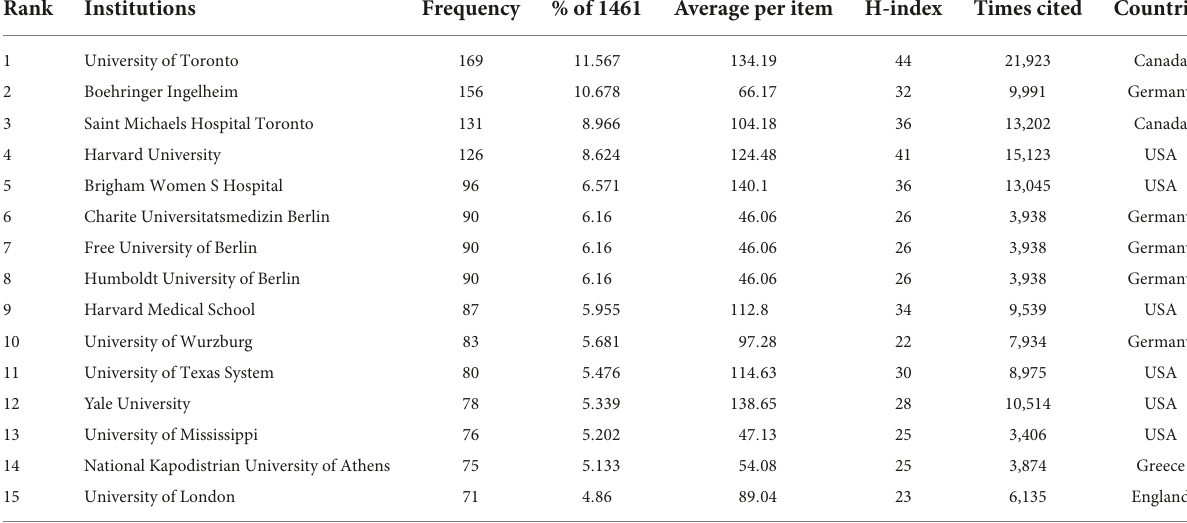
TABLE 5 Top 15 contributing institutions in the field of EMPA for